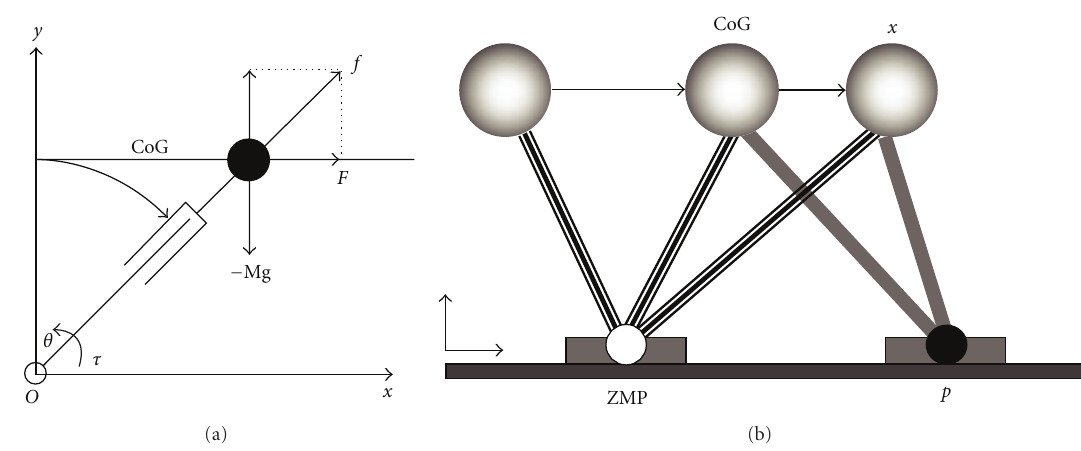
Figure 4: LIMP model and CoG transform model in sagittal plane.